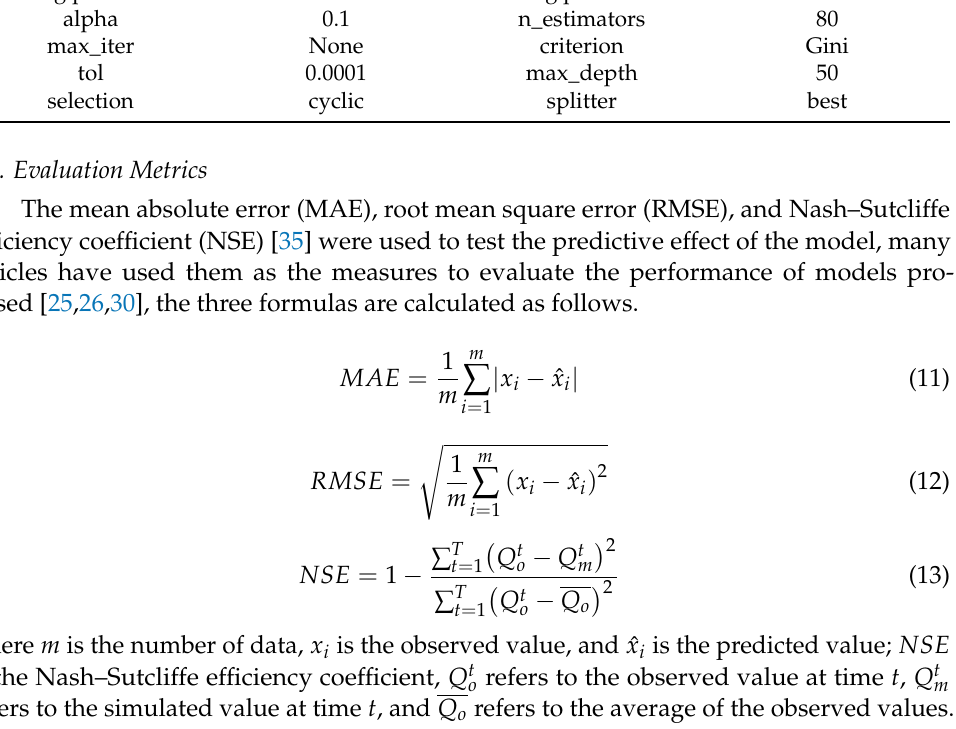
Table 4. Hyper-parameter settings of the LASSO and RF. LASSO RF Setting parameters Value Setting parameters Value 0.1 criterion Gini tol 0.0001 cyclic splitter best